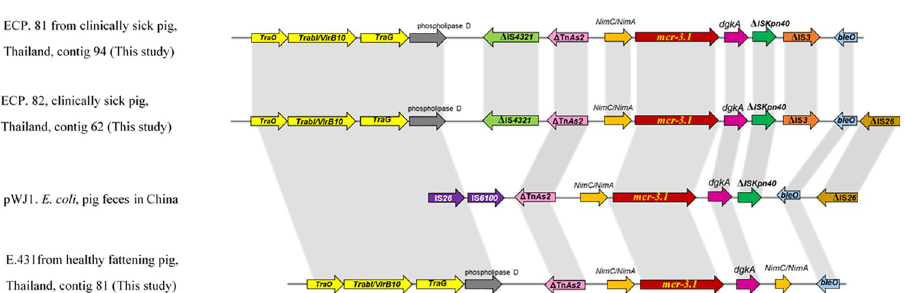
Fig 3. Comparative schematic representation of the flanking regions of the mcr-3 gene in pWJ1 (Accession no. KY924928) and mcr-3 carrying contigs in this study. The arrows indicate the positions and directions of the genes. The gray shade indicates homology in the corresponding genetic environment on each contig. AMR genes are indicated in red for mcr-3 . 1 and blue for bleO , bleomycin resistance gene. The conjugally-transferred proteins are indicated in yellow. The green, pink, orange and brown arrows represent transposon-associated genes ( Δ IS 4321 , Δ Tn As2 , Δ IS Kpn40 and Δ IS 26 ).